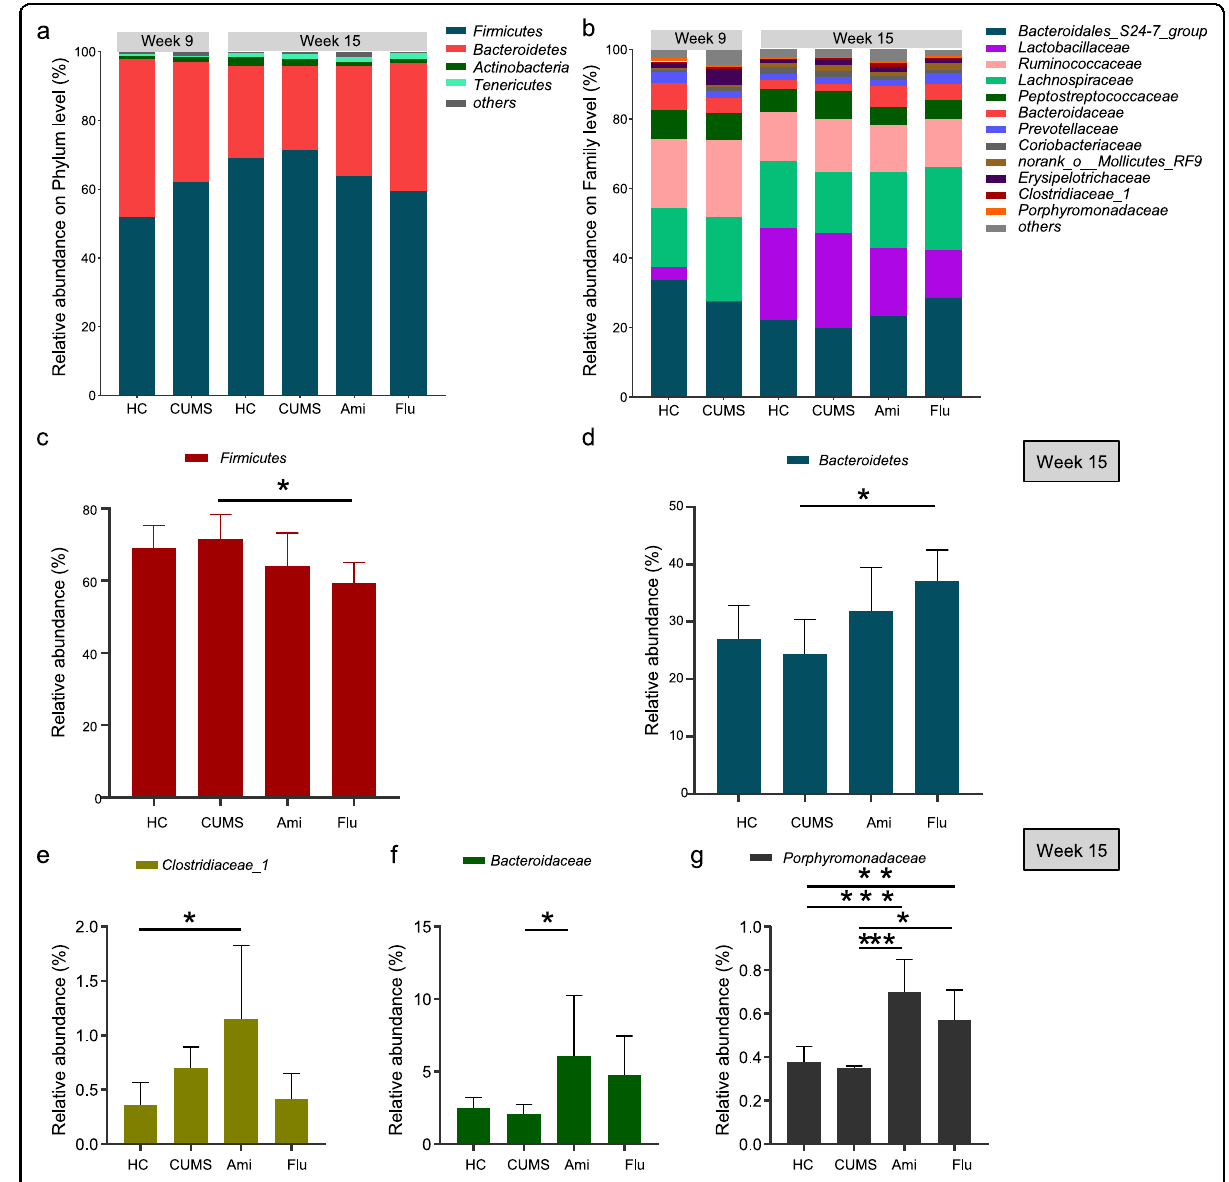
Fig. 3 Faecal microbiota changes following antidepressant treatments at the phylum and family levels. Community bar-plot analysis shows the relative abundance of sequences at a the phylum and b family levels. OTUs comprising less than 1% at the phylum and family level of the total abundance are represented as ‘ others ’ . Kruskal – Wallis H followed by Tukey ’ s posthoc tests statistics of the relative c , d bacterial phyla and e – g bacterial family abundances in HC, CUMS, Ami and Flu groups. Signi fi cant different are indicated: * P < 0.05, ** P < 0.01, *** P <